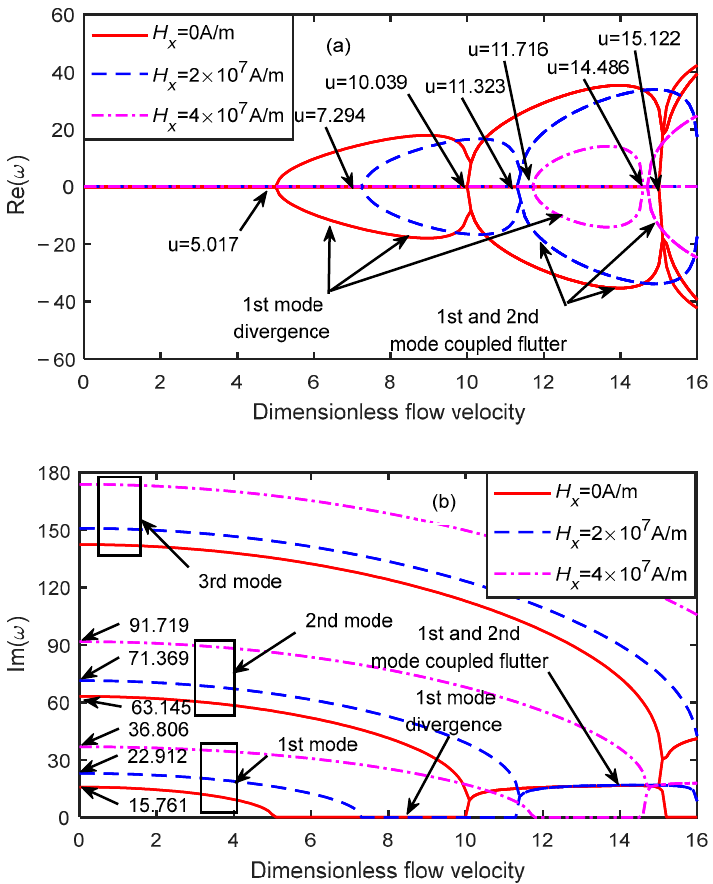
Figure 6. Dimensionless eigenfrequency variations with dimensionless flow velocity under different magnetic fields ( δ = 3 ). ( a ) Real part. ( b ) Imaginary part.